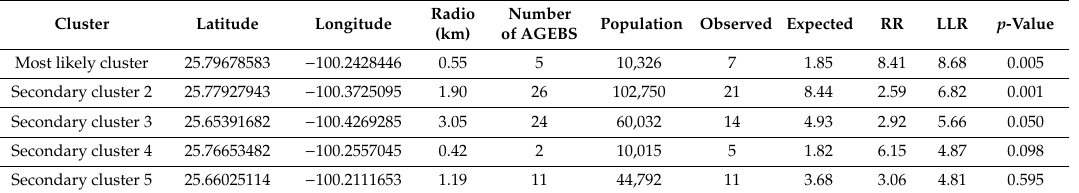
Table 7. Detected clusters by SaTScan.